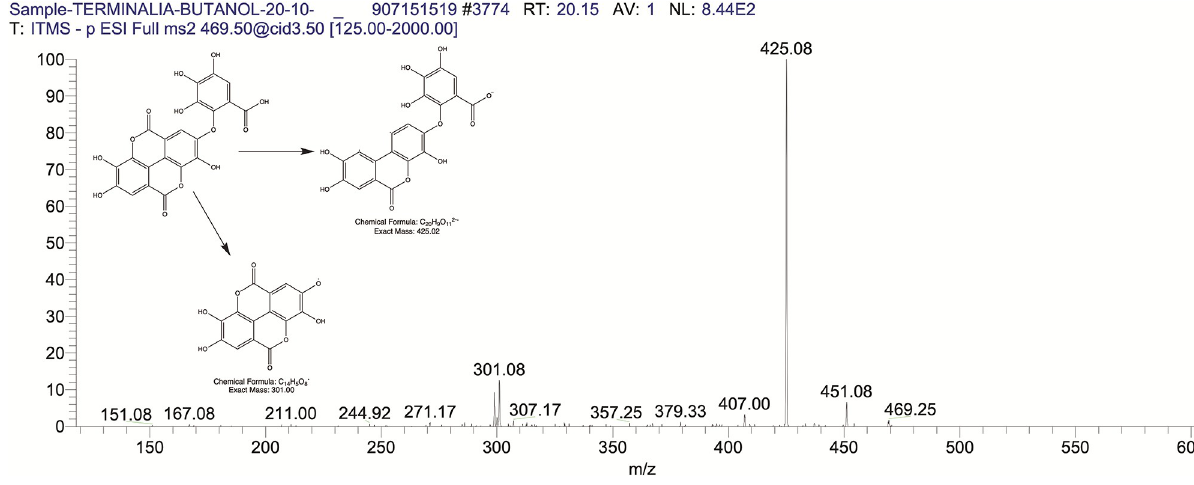
Fig 4. The mass spectrum of valoneic- dilactone and its fragmentation